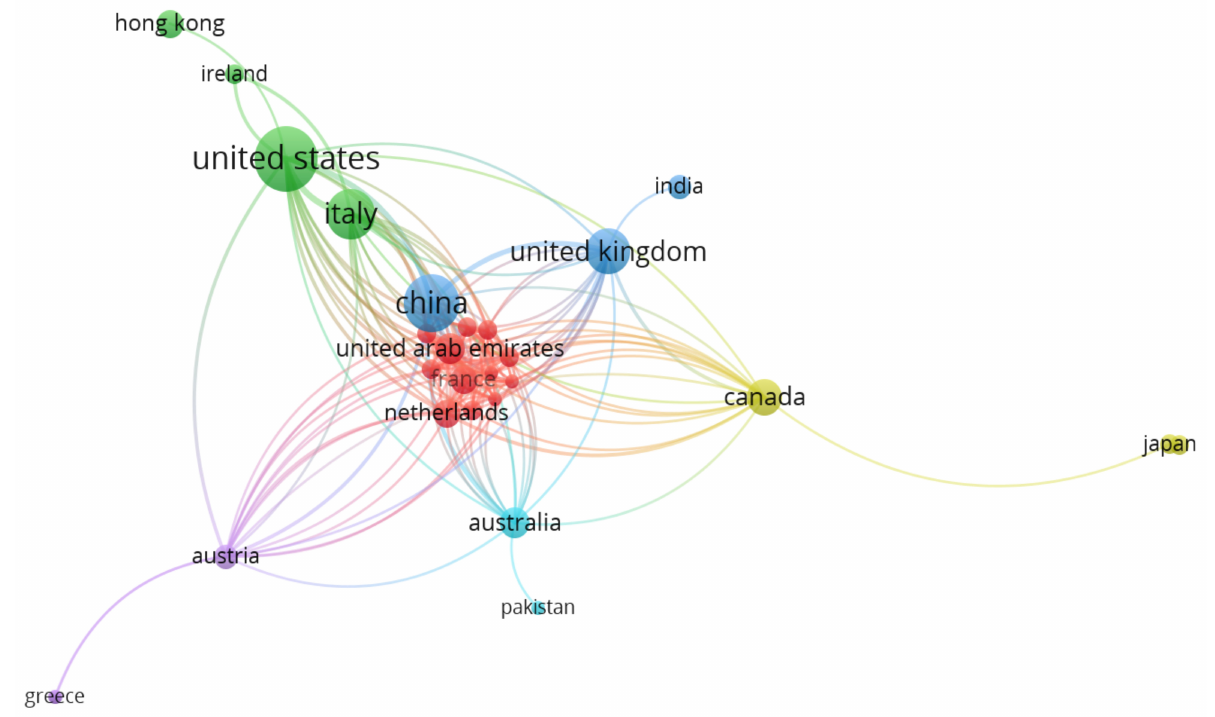
Figure 6. Network of countries/regions of research